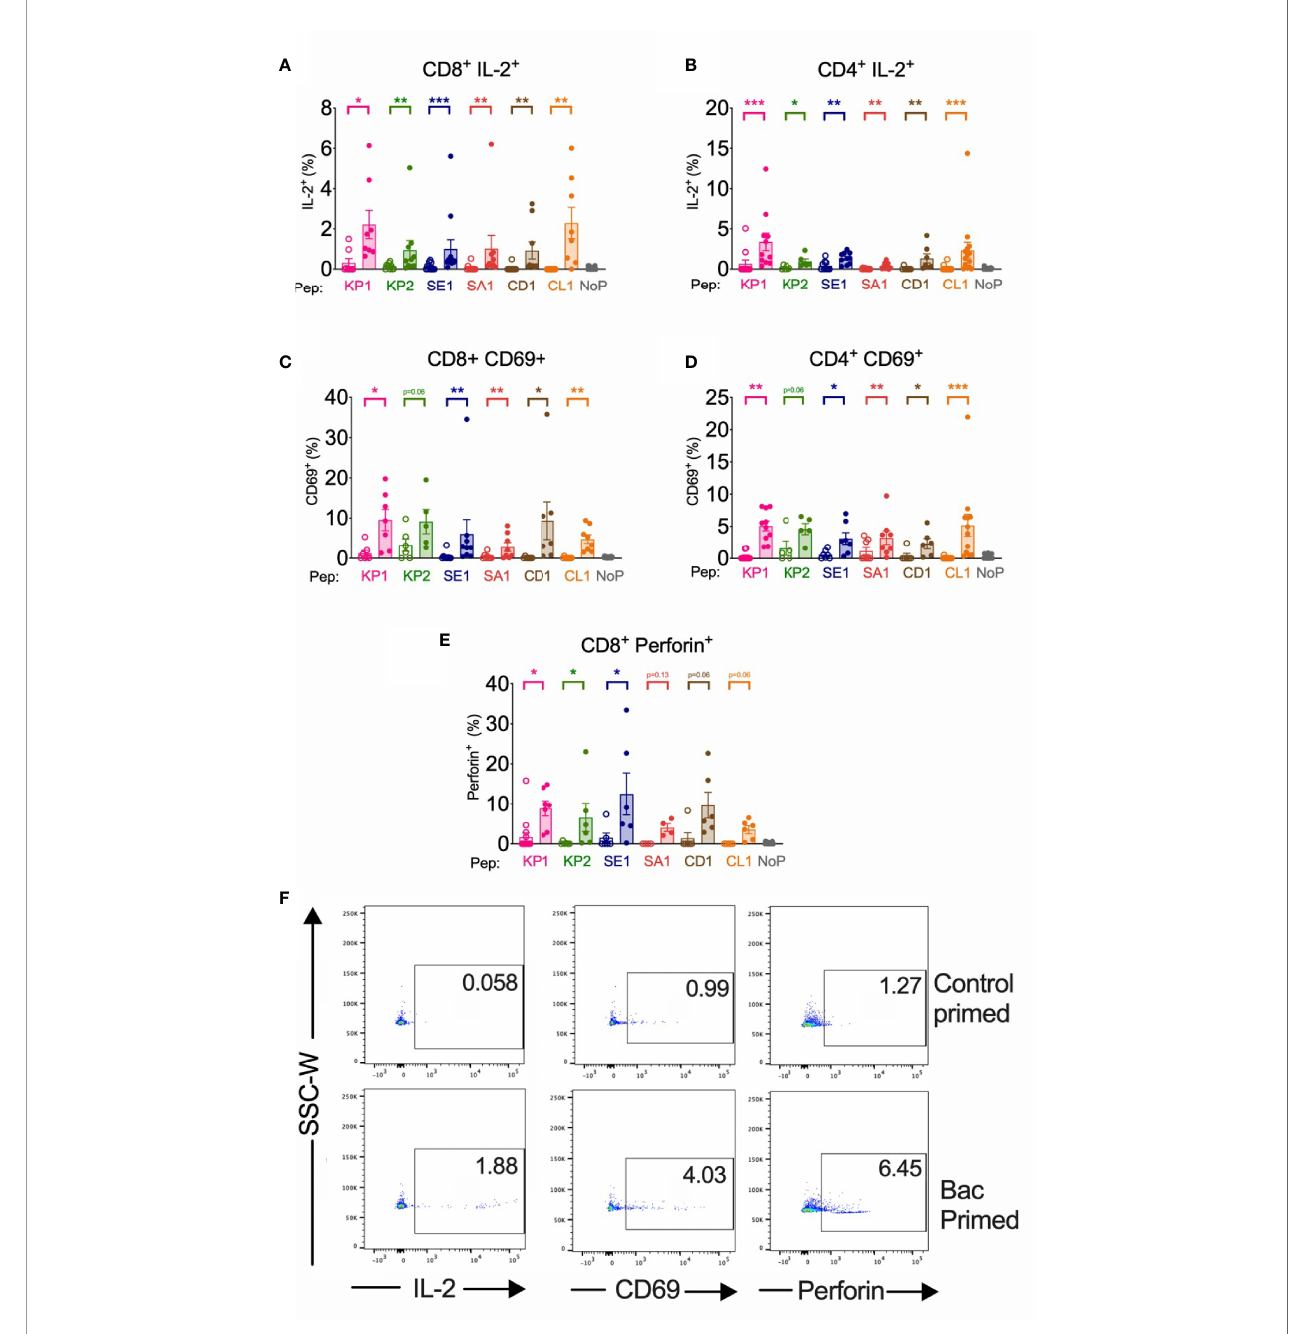
FIGURE 3 | | Bacterial peptide priming enhances IL-2, CD69 and Perforin T cell responses against SARS-CoV-2 in responders. Pathogenic bacterial-peptide (KP1, KP2, SE1, SA1, CD1 or CL1) primed (shaded bars) or control primed with irrelevant peptide (unshaded bars) CD3 + T cells were restimulated with SARS-CoV-2- peptide-homologue-pulsed DCs for 6 hours and analysed by fl ow cytometry with background control values subtracted. NoP – no peptide negative control. *P<0.05, **P<0.01, ***P<0.001 by Wilcoxon matched-pairs signed rank test. (A) CD8 + IL-2 + responses (n=8-12). (B) CD4 + IL-2 + responses (n=6-14). (C) CD8 + CD69 + responses (n=5-9). (D) CD4 + CD69 + responses (n=5-12). (E) CD8 + Perforin + responses (n=4-15). (F) Representative donor T cell IL-2, CD69 and perforin dot plots of responder control-primed (top) and bacterial peptide (bac)-primed